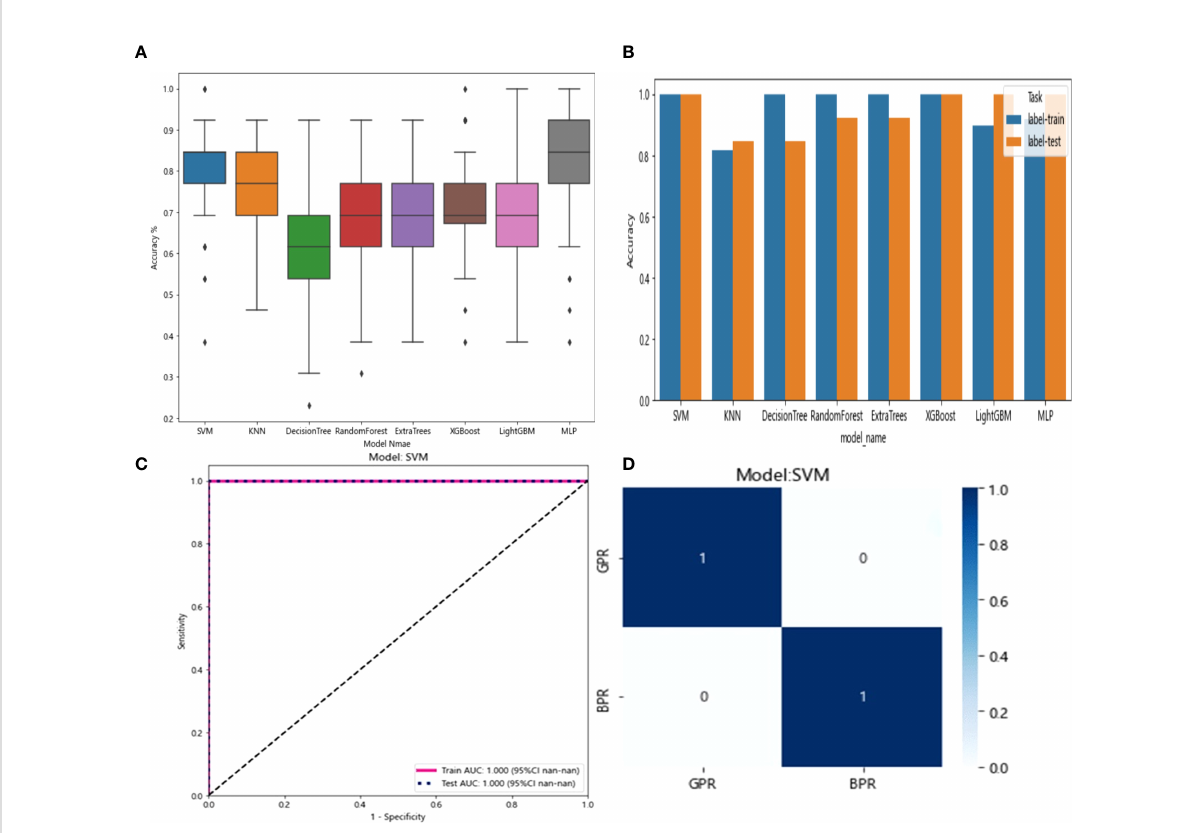
FIGURE 13 (A) Distribution of the accuracy of each model randomly tested 100 times by eight common machine learning algorithms. (B) Comparison of the accuracy of the best performing one out of 100 randomizations in eight machine learning algorithms. (C) AUCs of the training set and test set in the SVM model. (D) Confusion matrix for the SVM model.